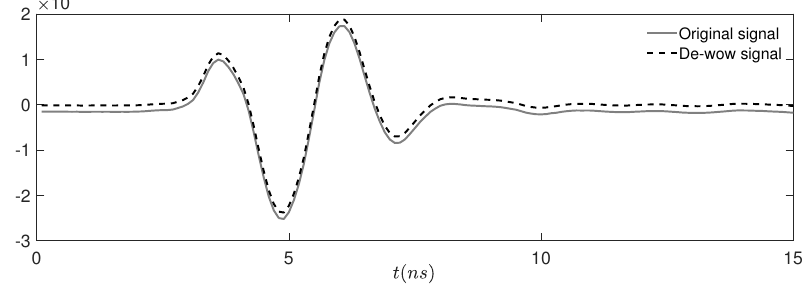
Figure 3. De-“wow” results of a representative GPR trace.